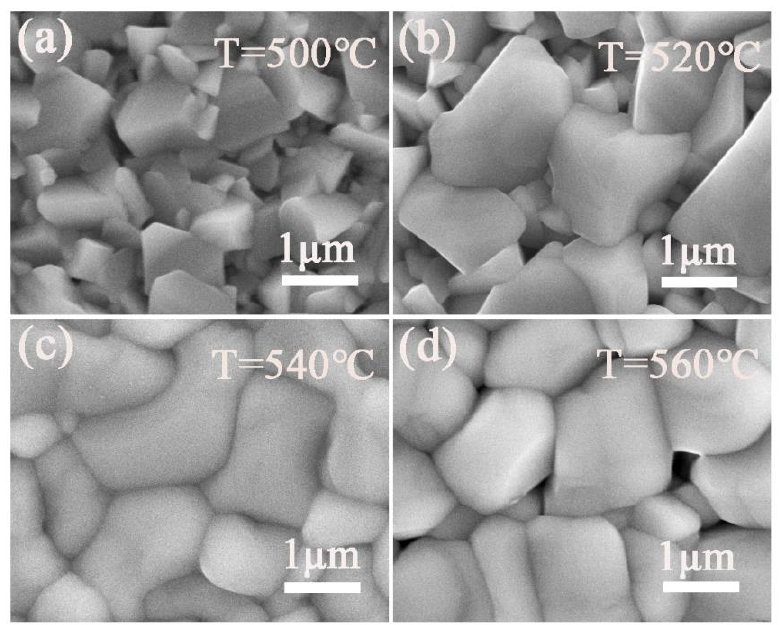
Figure 7. SEM surface images of the CNZTSSe thin films selenized at 500 °C ( a ), 520 °C ( b ), 540 °C ( c ), and 560 °C ( d ).